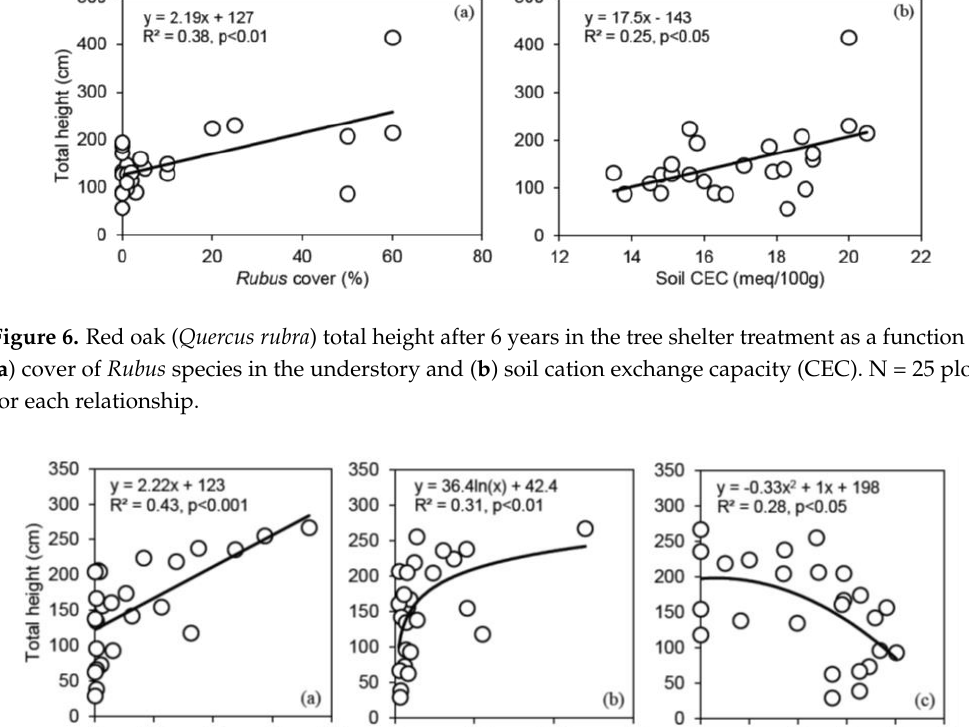
Figure 5. White pine ( Pinus strobus ) total height after 6 years in the tree shelter treatment as a function of ( a ) canopy openness, ( b ) soil cation exchange capacity (CEC) and ( c ) basal area (BA) of grey birch ( Betula populifolia ) in the overstory. N = 25 plots for each relationship.